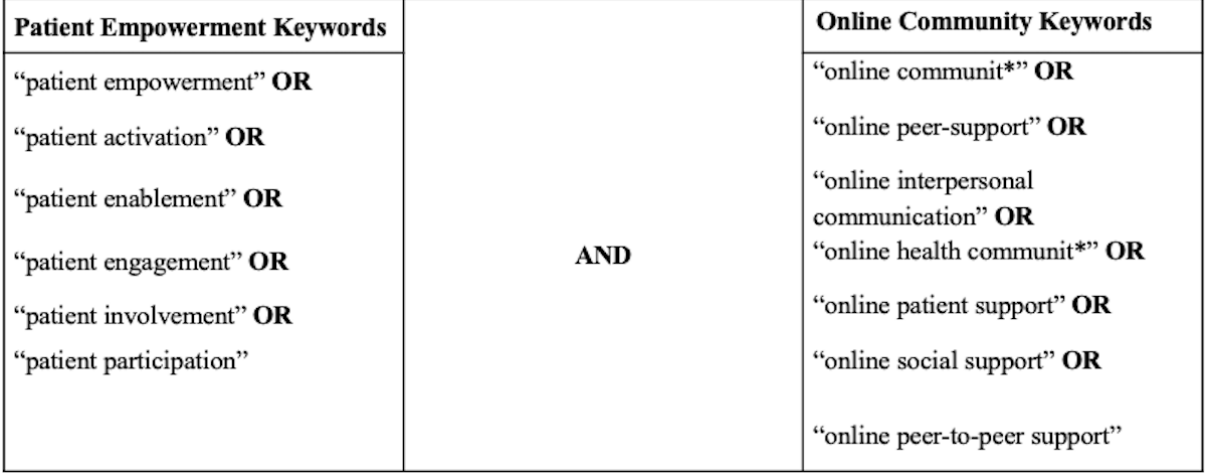
Figure 1. Main search